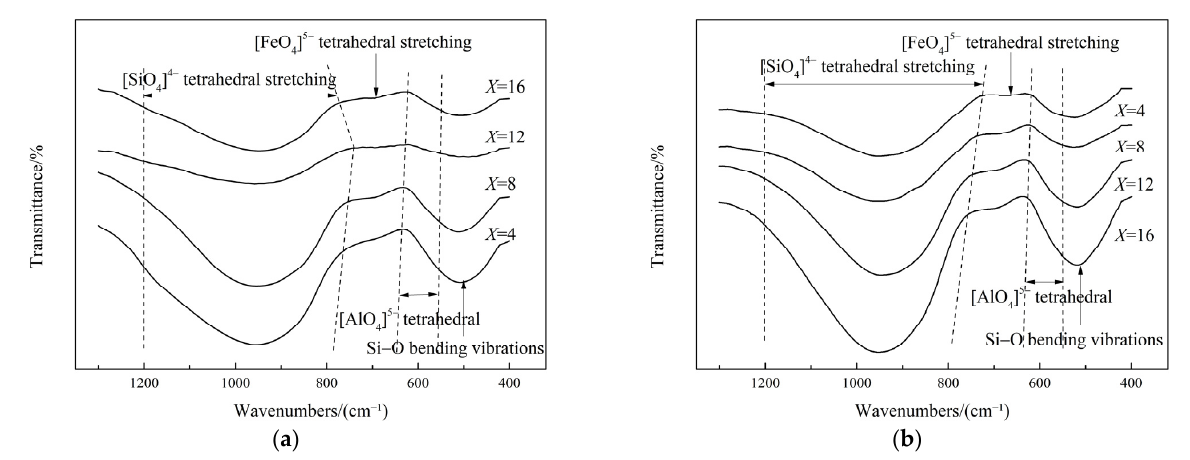
( b ) Figure 11. Effect of Fe 2 O 3 on the FeO − Fe 2 O 3 − SiO 2 − 8 wt%CaO − 3 wt%MgO − 3 wt%Al 2 O 3 slag viscosity at fixed temperatures and Fe/SiO 2 ratios: ( a ) results of experimental tests; ( b ) results of simulation tests by Factsage 7.3. 3.6. Effect of Fe 2 O 3 on the Slag Structure